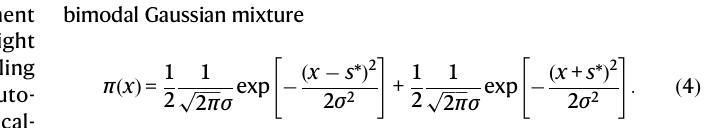
Fig.5|Propertiesofdifferentsamplingapproaches.a Samplingprocessesdriven byfractionalLévymotion( α =1.2,toptwopanels)exhibitlongjumps,incontrastto their non-fractional counterparts ( α =2, bottom two panels). Right panels: sample histograms agree with the target distributions (dashed line). b Autocorrelation functions of different sampling processes. The processes with momentum ( β =1)